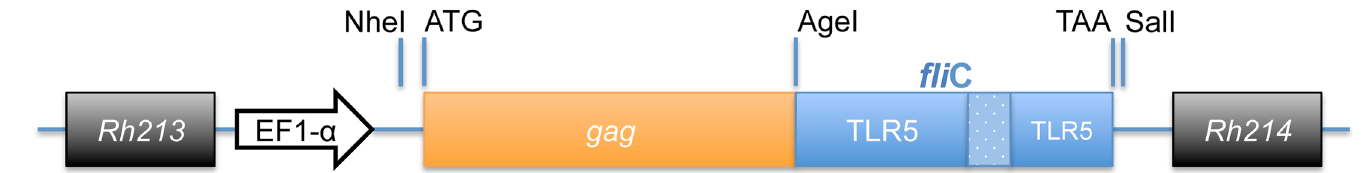
Fig 4. RhCMV gagfliC Δ 196 – 378 virus map. The SIV gag -Salmonella fliC fusion gene was cloned from the expression plasmid pORI gagfliC Δ 196 – 378 into a BAC encoding the RhCMV 68 – 1 genome. The insertion site was in the intergenic region between Rh213 and Rh214 of the RhCMV genome. The open arrow indicates the EF1- α promoter. The start and stop codons and the restriction endonuclease sites used in the cloning process are indicated above the colored bars. The orange bar indicates SIV gag . The solid blue bars designate the conserved carboxyl and amino termini of fliC , containing the TLR5 binding domains. The light blue bar with white dots designates the partially truncated fliC hypervariable domain.